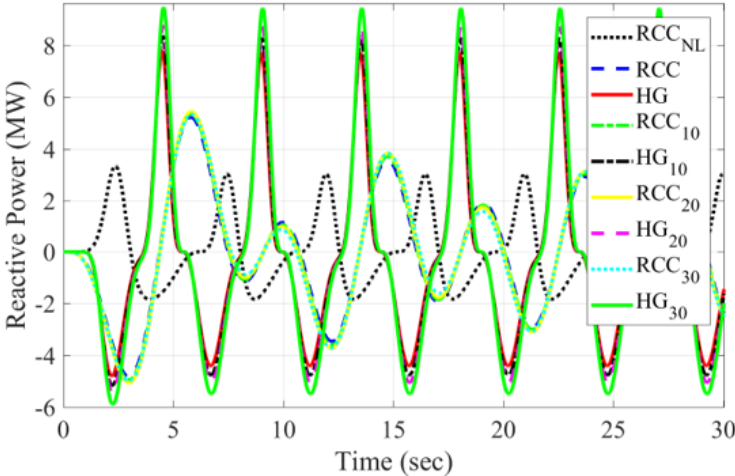
Figure 14. Reactive powers for the first 30 s of 100 s duration for all cases, respectively.